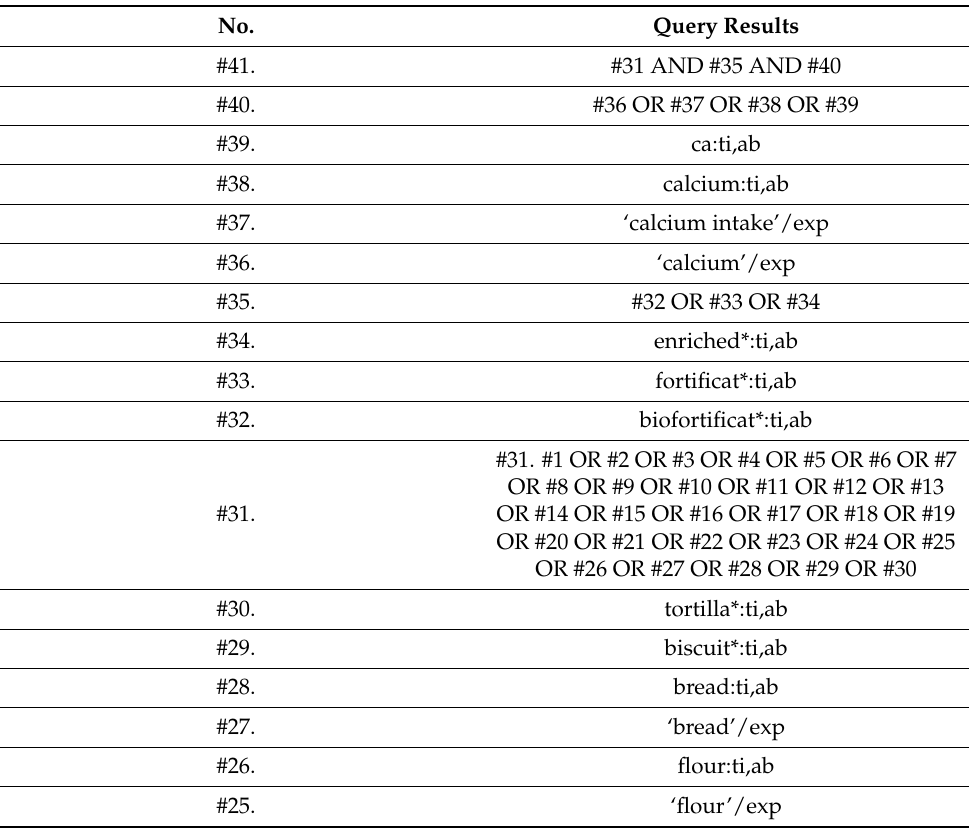
Table A1. Search strategy for identification of studies and data